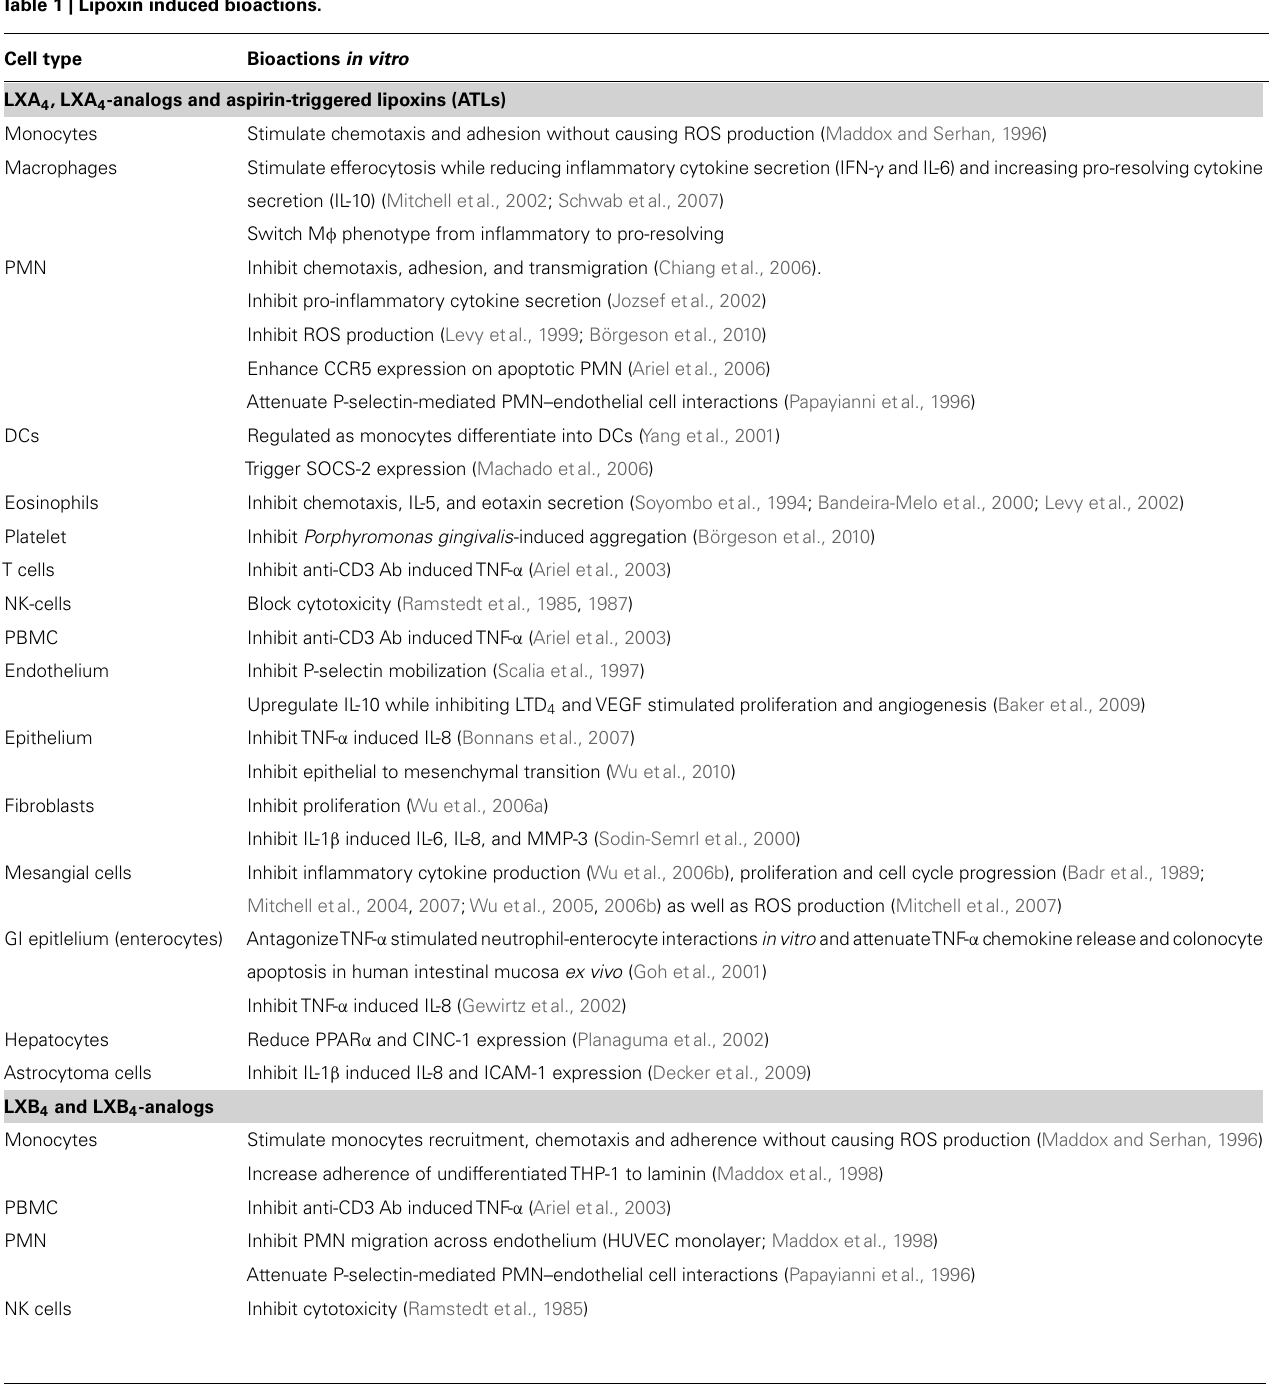
Table 1 | Lipoxin induced